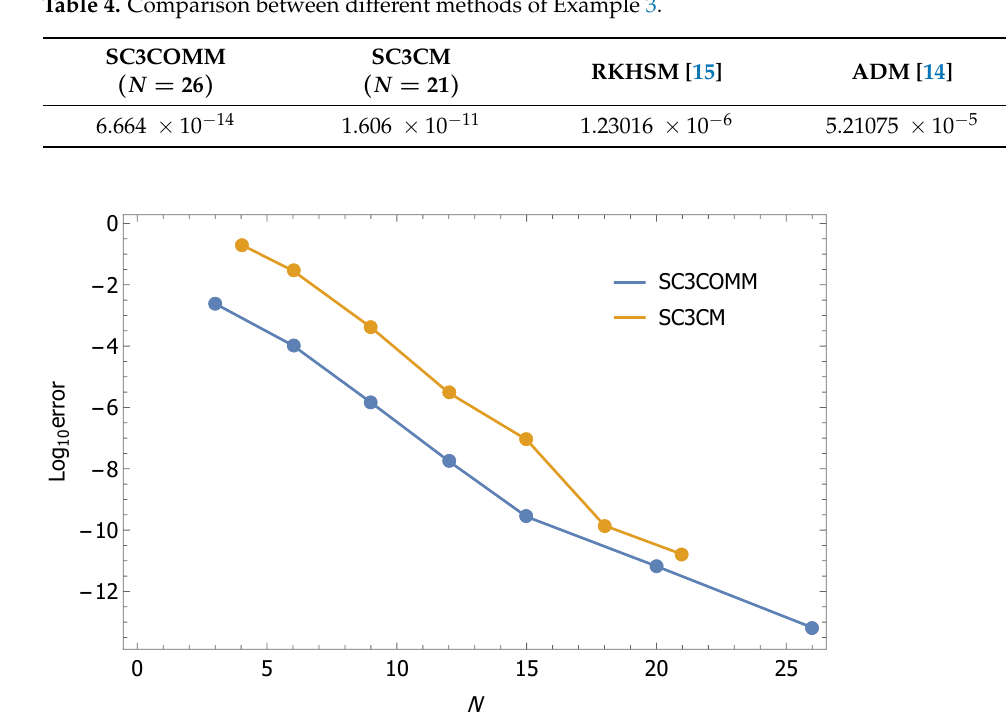
Table 4. Comparison between different methods of Example 3.